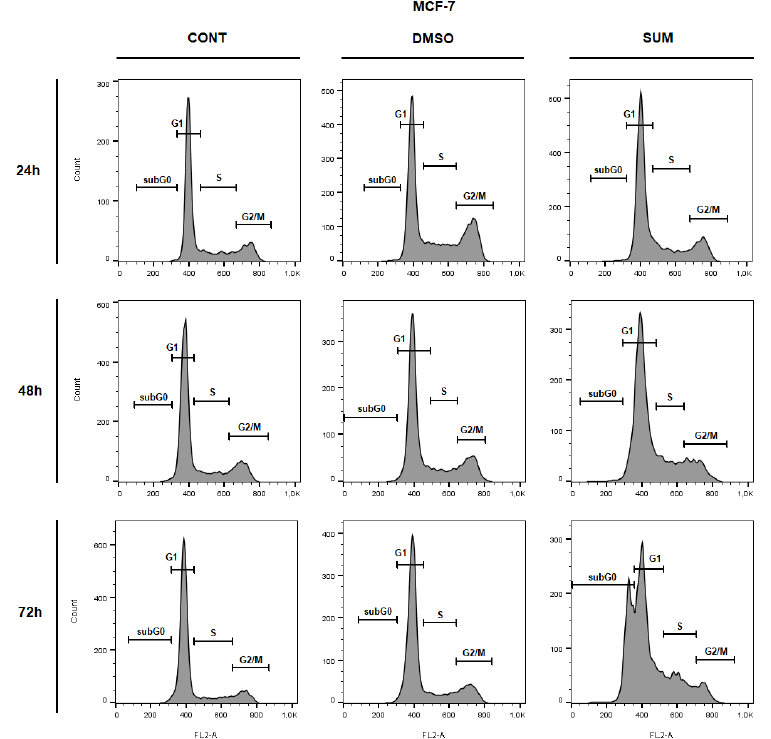
Figure 10. Representative diagrams of cell cycle distribution in MCF-7 cells after SUM treatment (155 µg/mL).